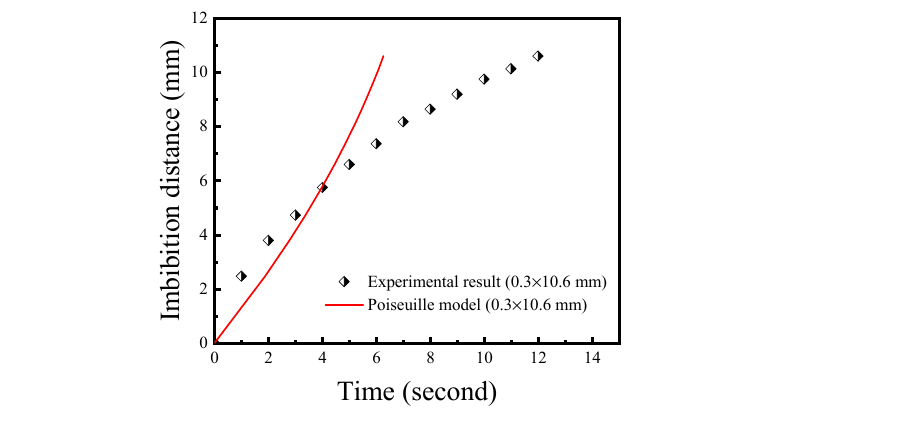
Figure 6. Comparison diagram of experimental data and Poiseuille model curve of imbibition experiments of water-displacing-oil in circular single channel.